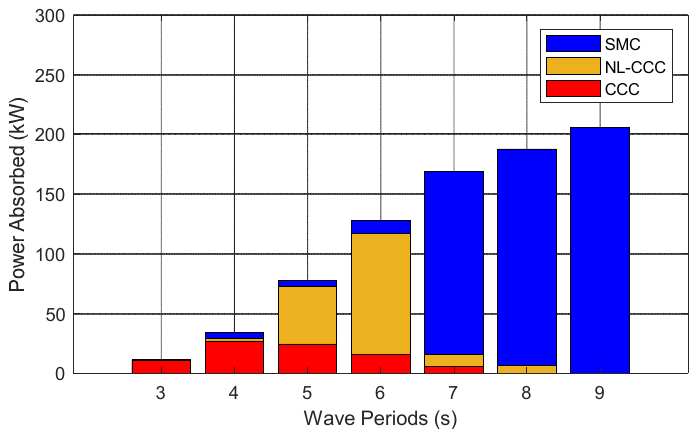
Figure 7. Absorbed Power for the different control strategies with varying wave periods and constant steepness of regular waves.